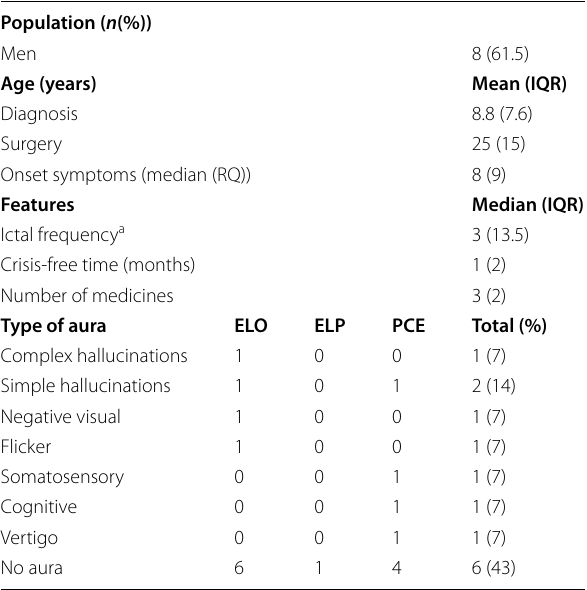
Table 2 Demographics and clinical characteristics